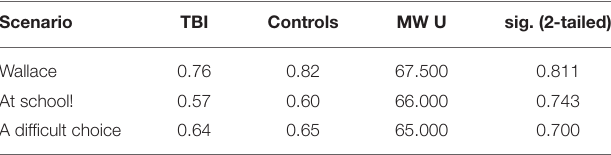
TABLE 4 | Actor studio: simple matching coefficients (all emotions). Scenario